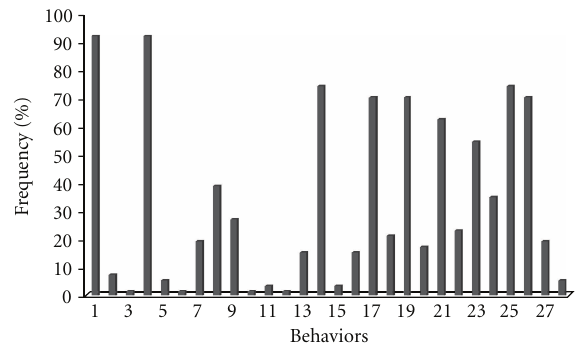
Figure 3: Frequency of predatory behaviors of Canthon